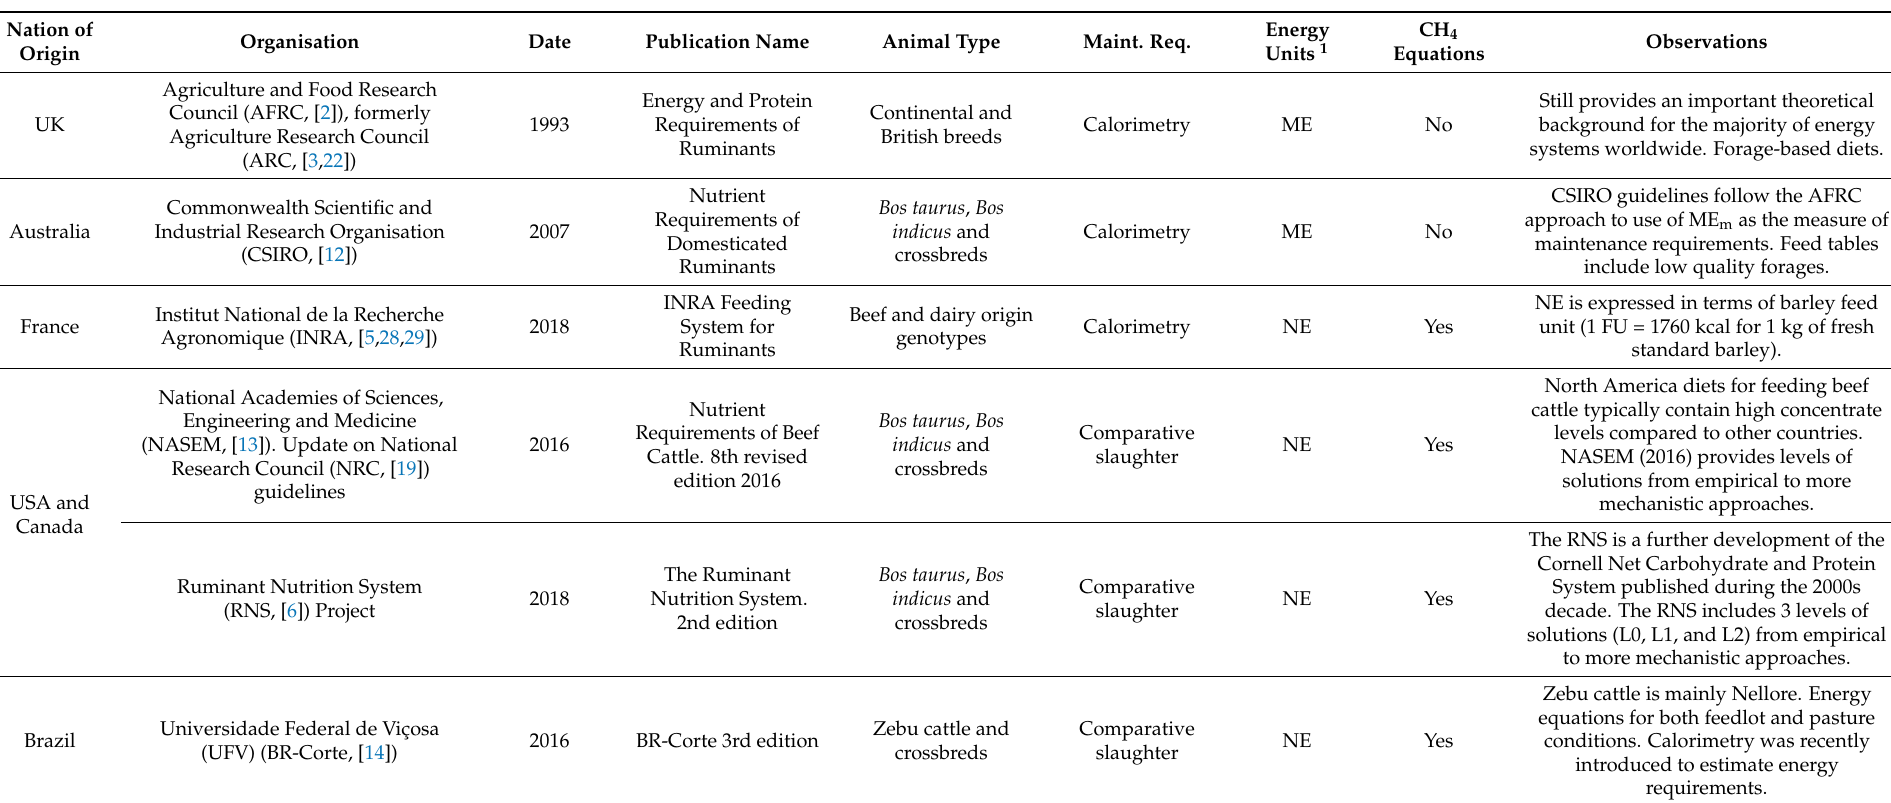
Table 1. General descriptors of international nutritional models on determination of energy requirements for beef cattle 1